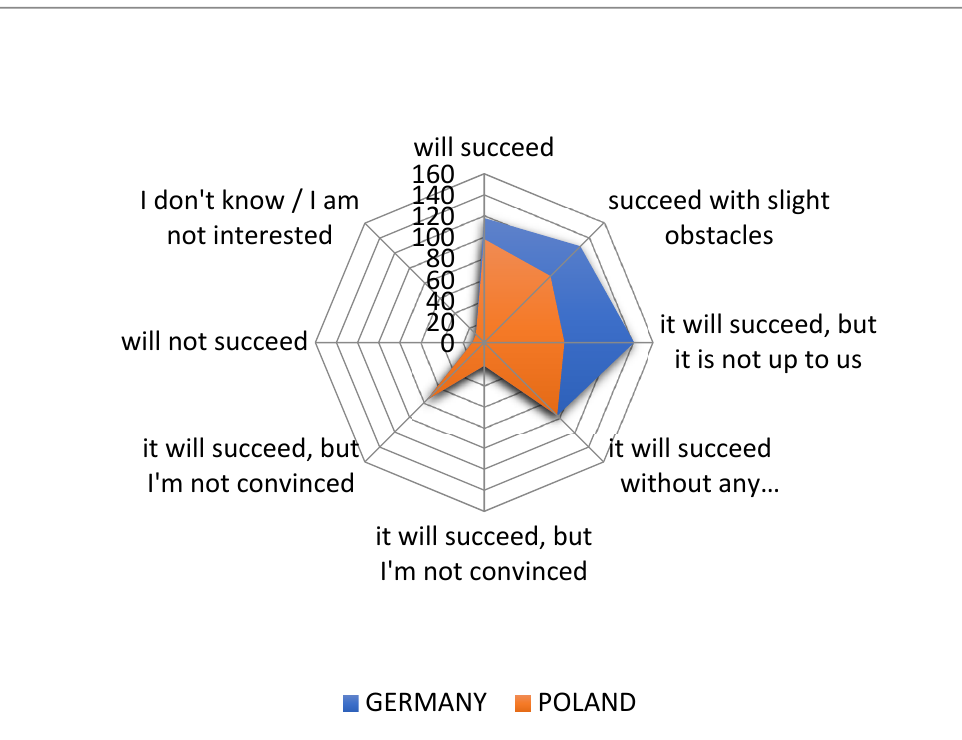
Figure 20. Opinion of individuals actively using innovations in Poland and Germany (number of people).